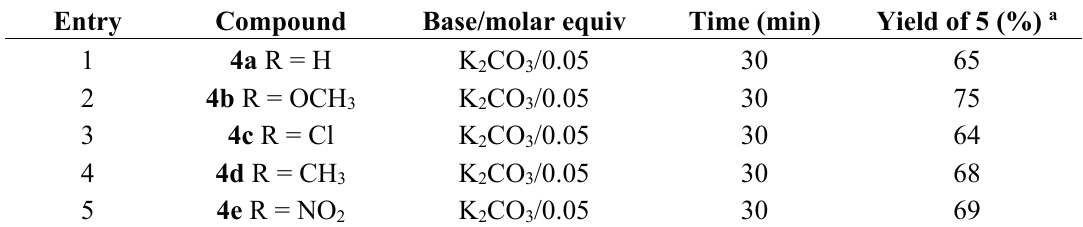
Table 3. Cyclodehydration of 5-aryl-1-(2-hydroxyphenyl)pent-4-ene-1,3-diones 4a – e to ( E )-2-styrylchromones 5a – e in water and in the presence of a catalytic amount of K 2 CO 3 , using closed vessel microwave conditions, at 200 °C. Entry Compound Base/molar